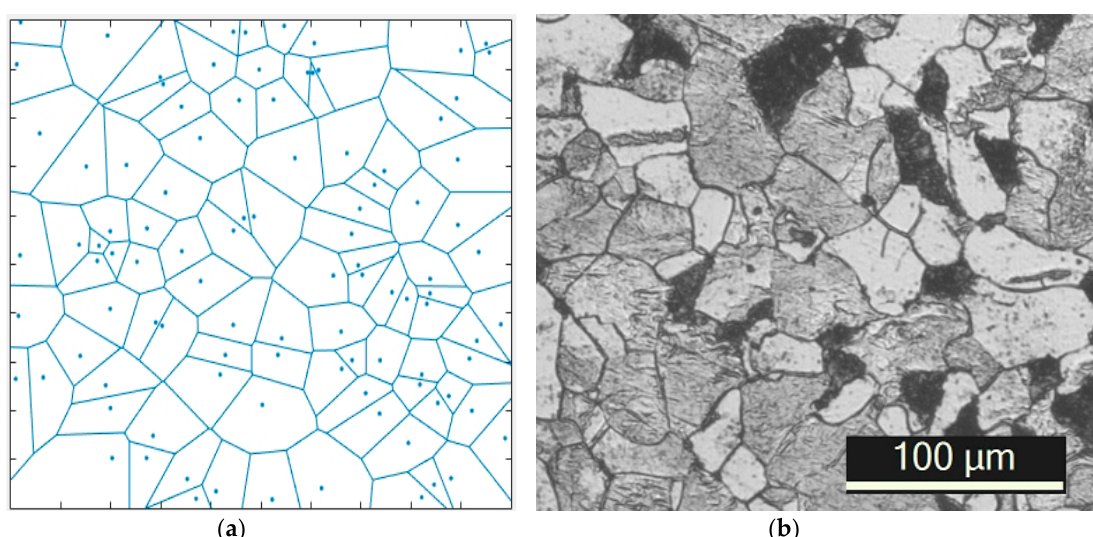
Figure 4. Grain size diagram of ( a ) polycrystalline Voronoi diagram in MATLAB and ( b ) actual grain size of the beam blank.